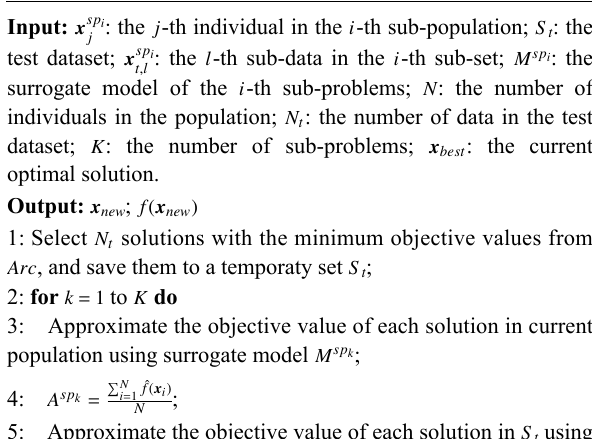
Algorithm 2 Dynamic infill